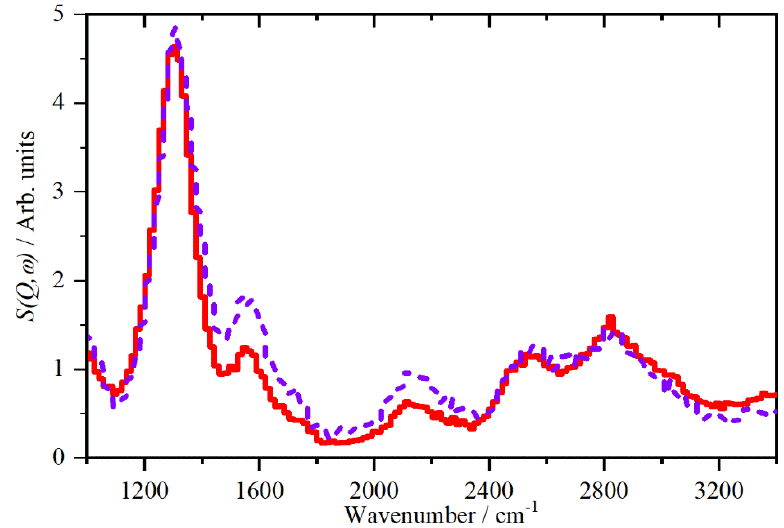
Figure 4. INS spectra recorded with MAPS of CsHSO 4 in phase II at 10 K. The solid line is for the range 4 ≤ Q ≤ 10 Å − 1 and the dashed line for 10 ≤ Q ≤ 16 Å − 1 .